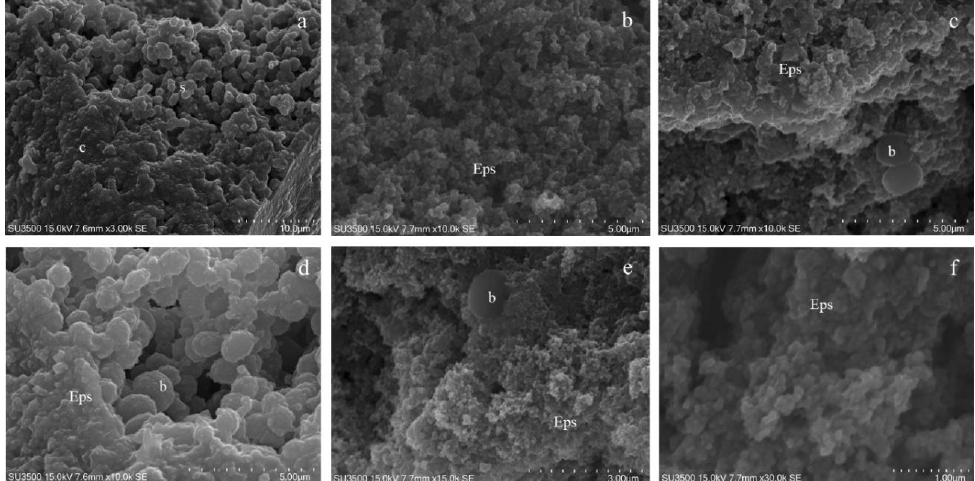
Figure 3. S. mutans prepared by the OsO 4 -RR-TA-IL procedure. ( a ) OsO 4 -RR-TA-IL 3000×. The biofilm topography shows both a compact, c, and spongy, s, appearance. Micro-canalicular system is well developed. ( b ) OsO 4 -RR-TA-IL 10000×. At a high magnification, the strength of this technique is revealed, and high-resolution images were obtained without artifacts formation. Eps appears soft, with no signs of collapse or shrinking; micro-canalicular system is intricate. ( c ) OsO 4 -RR-TA-IL10000×. Bacterial cells b appeared surrounded by the Eps, spherical and smooth: no shape alterations were found. ( d ) OsO 4 -RR-TA-IL10000× Bacterial cells b are completely embedded in the Eps. ( e ) OsO 4 -RR-TA-IL15000×. High-voltage, high-magnification and high-resolution image of fully hydrated biofilm, where a single bacterial cell b is partially embedded in the Eps. ( f ) OsO 4 -RR-TA-IL 30000×. Very high magnification image confirms the value of this protocol in terms of biofilm three-dimensional structure preservation, until the nanometric level.